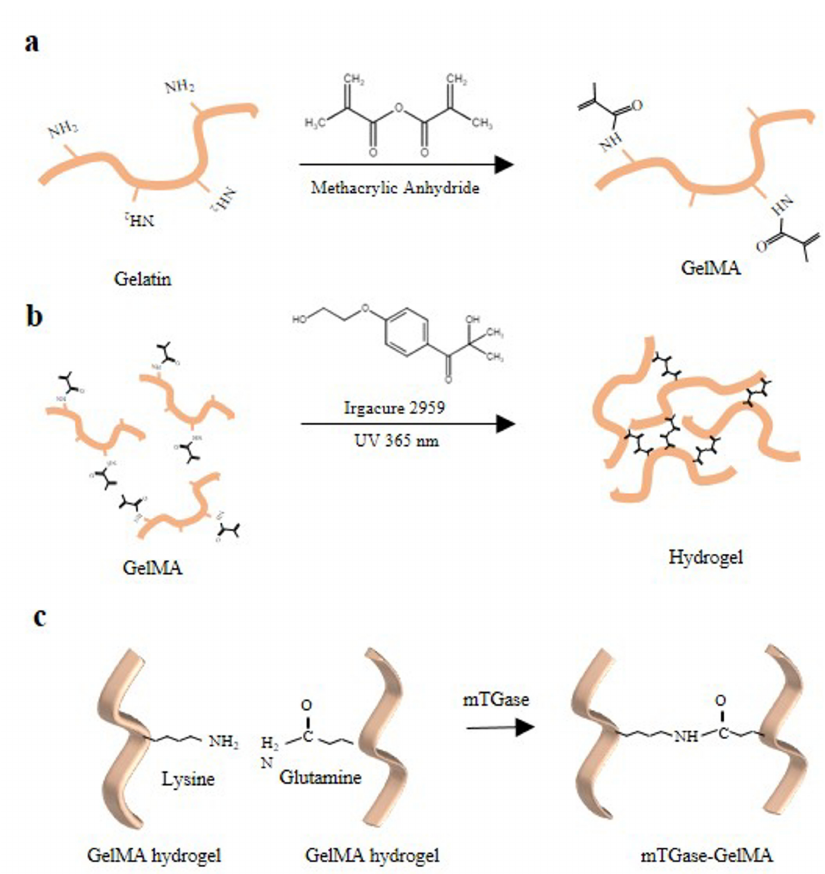
Figure 1. Schematic elucidating the crosslinking mechanism of GelMA ( a ) Modification of gelatin to GelMA ( b ) Photocrosslinking of GelMA hydrogel ( c ) Enzymatic crosslinking of GelMA